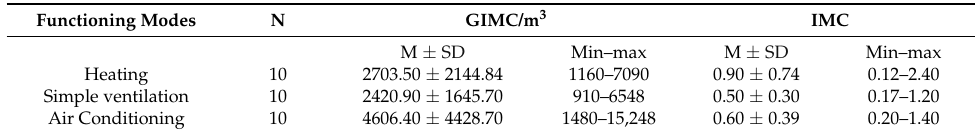
GIMC/m 3 and IMC measured in gyms during heating, air conditioning, and simple ventilation.